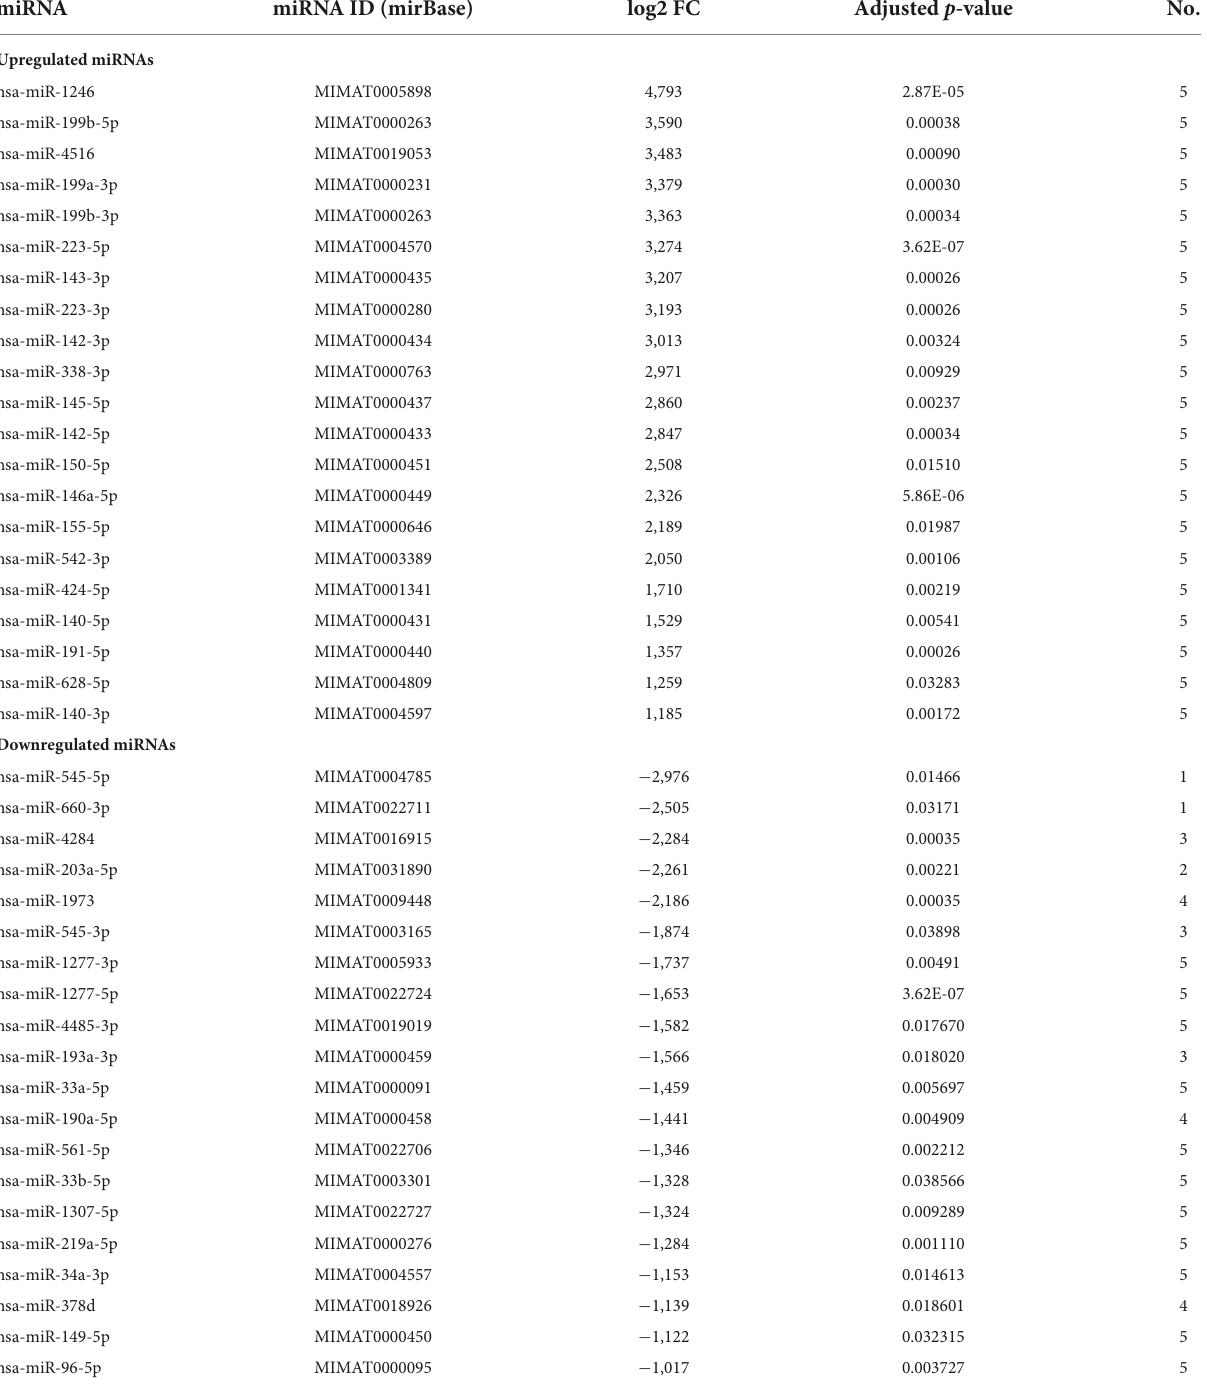
TABLE 3 miRNAs expression in ASD compared to healthy